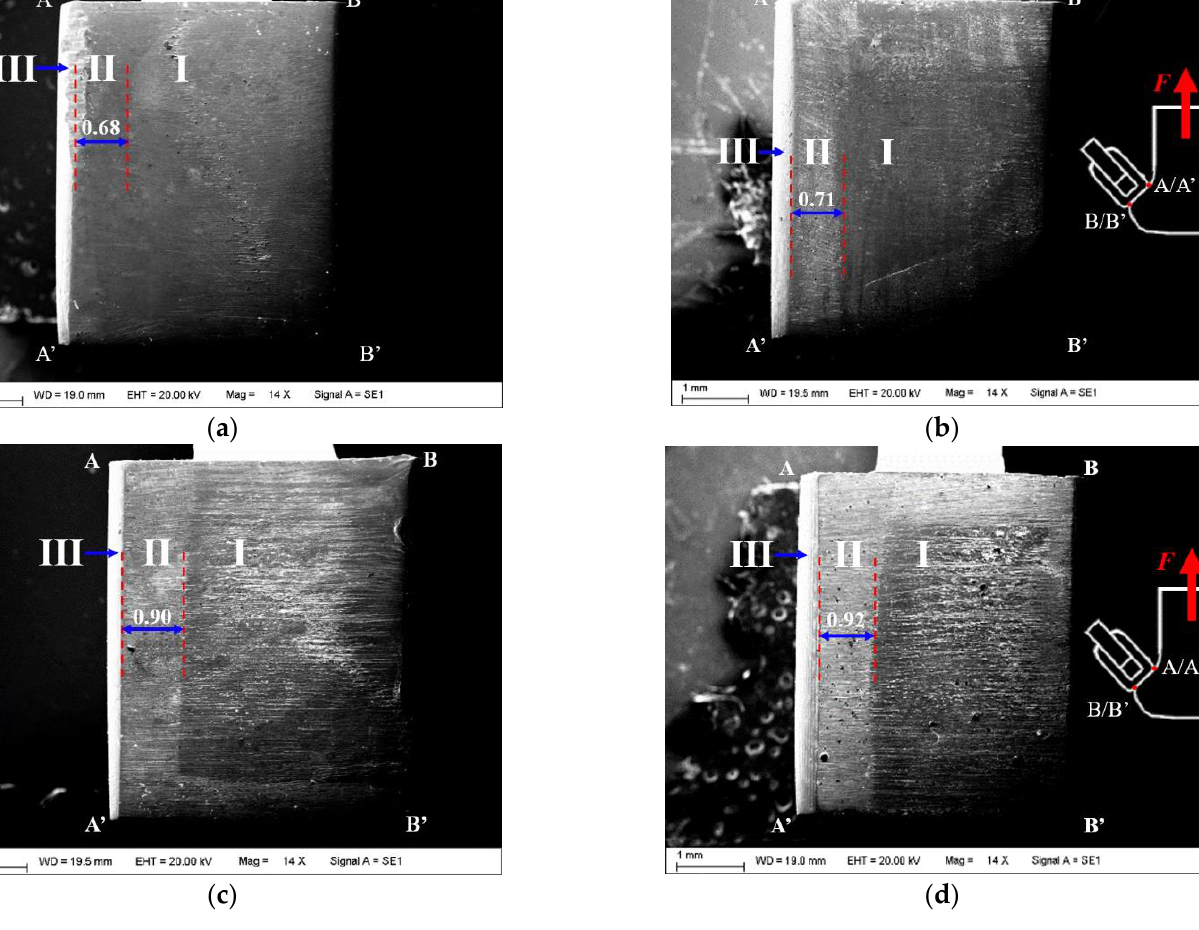
Figure 9. Wear morphology of the fretting surfaces for four loading conditions (unit: mm). ( a ) 13,500N; ( b ) 14,956N; ( c )